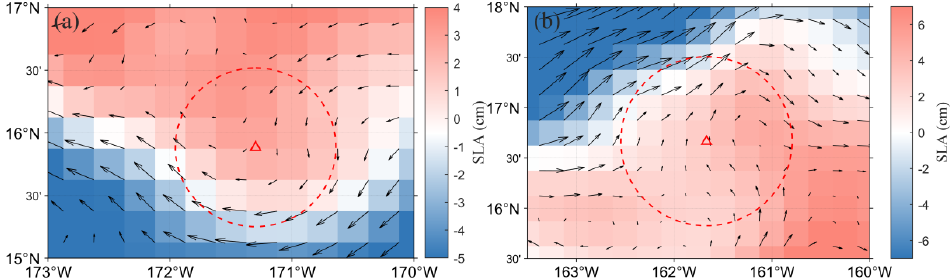
Figure 21. Snapshots of eddy identification errors as identified by the META dataset on ( a ) 5 January 2019, and ( b ) 24 March 2019, in the SF region. The triangle represents the center of the META eddy. Dashed curves represent the circle corresponding to the eddy radius of the META dataset.